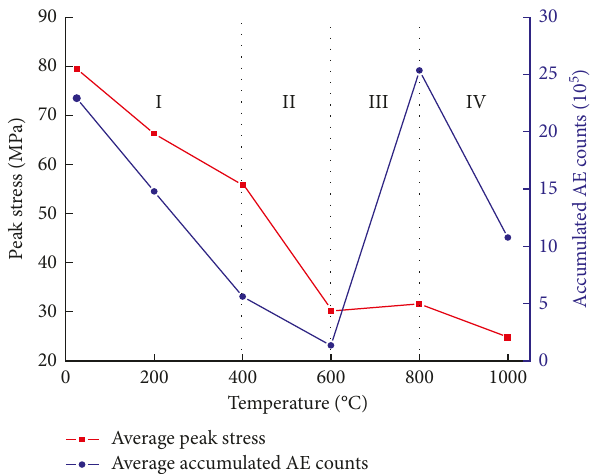
Figure 6: Average peak stress and accumulative AE counts with temperature.